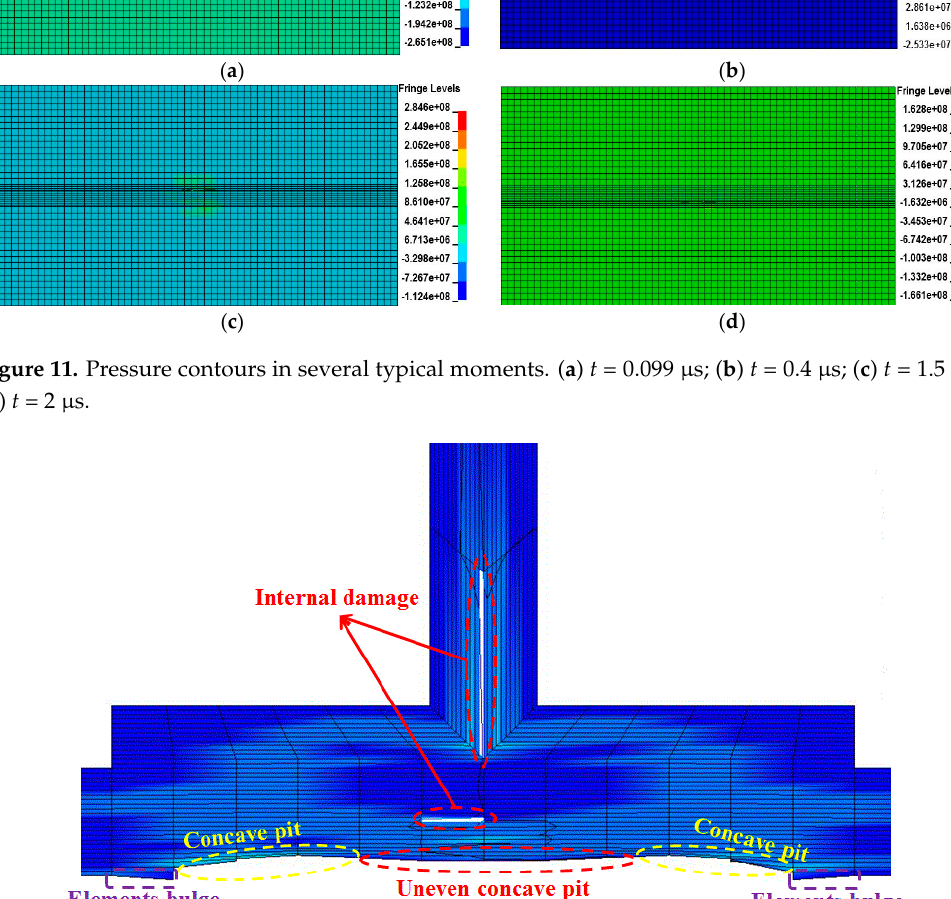
( b ) ( c ) Figure 13. Pressure contours in blow-off impulse elements. ( a ) t = 0.0096 µs; ( b ) t = 1 µs; ( c ) t = 2 µs. 0.00 0.25 0.50 0.75 1.00 1.25 1.50 1.75 2.000.00E+0005.00E+0081.00E+0091.50E+009 2.00E+009 2.50E+0093.00E+0093.50E+0094.00E+0094.50E+009 P r e ss u r e / N Time/ us Pressure of blow-off impulse elements Figure 14. Pressure change of blow-off impulse elements.